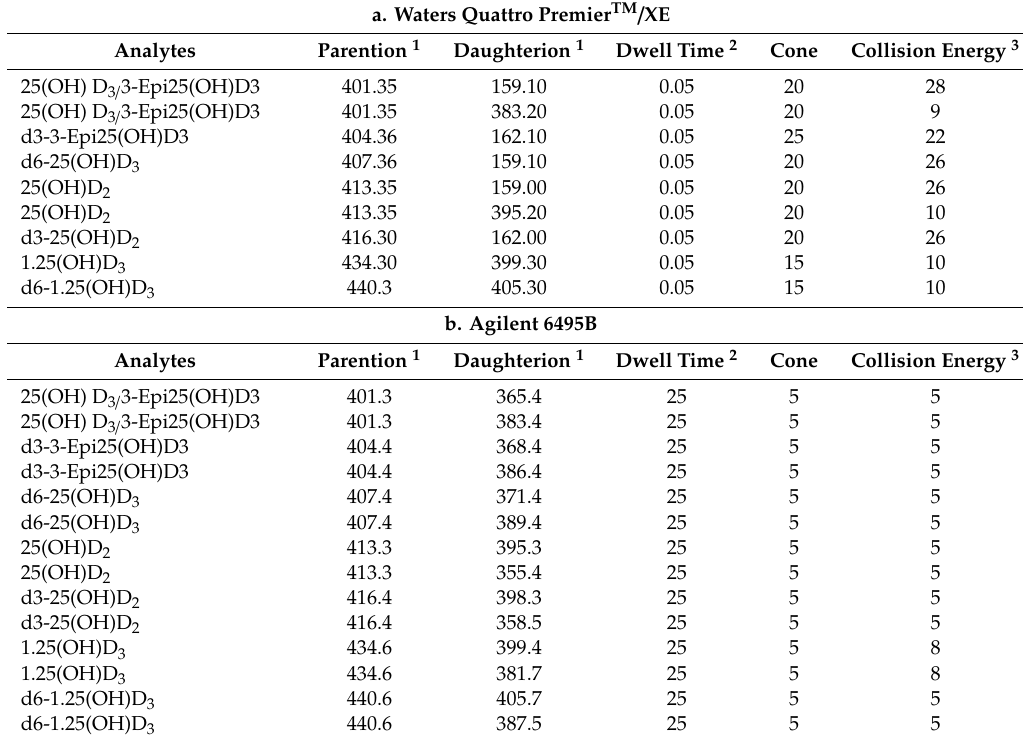
Table A1. Multiple-reaction monitoring (MRM) mode and the respective dwell time, cone voltage, and collision energy used in Waters Quattro Premier TM / XE ( a ) and in Agilent 6495B ( b